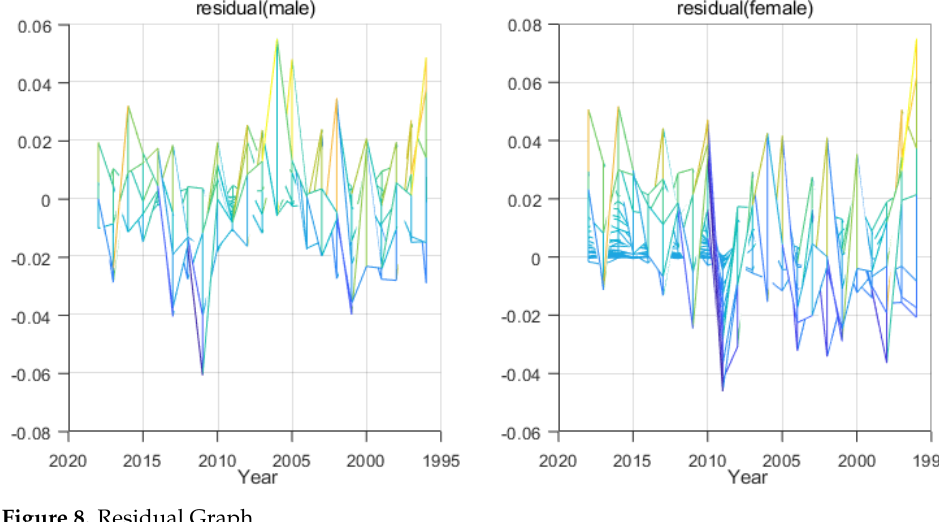
Figure 8. Residual Graph.